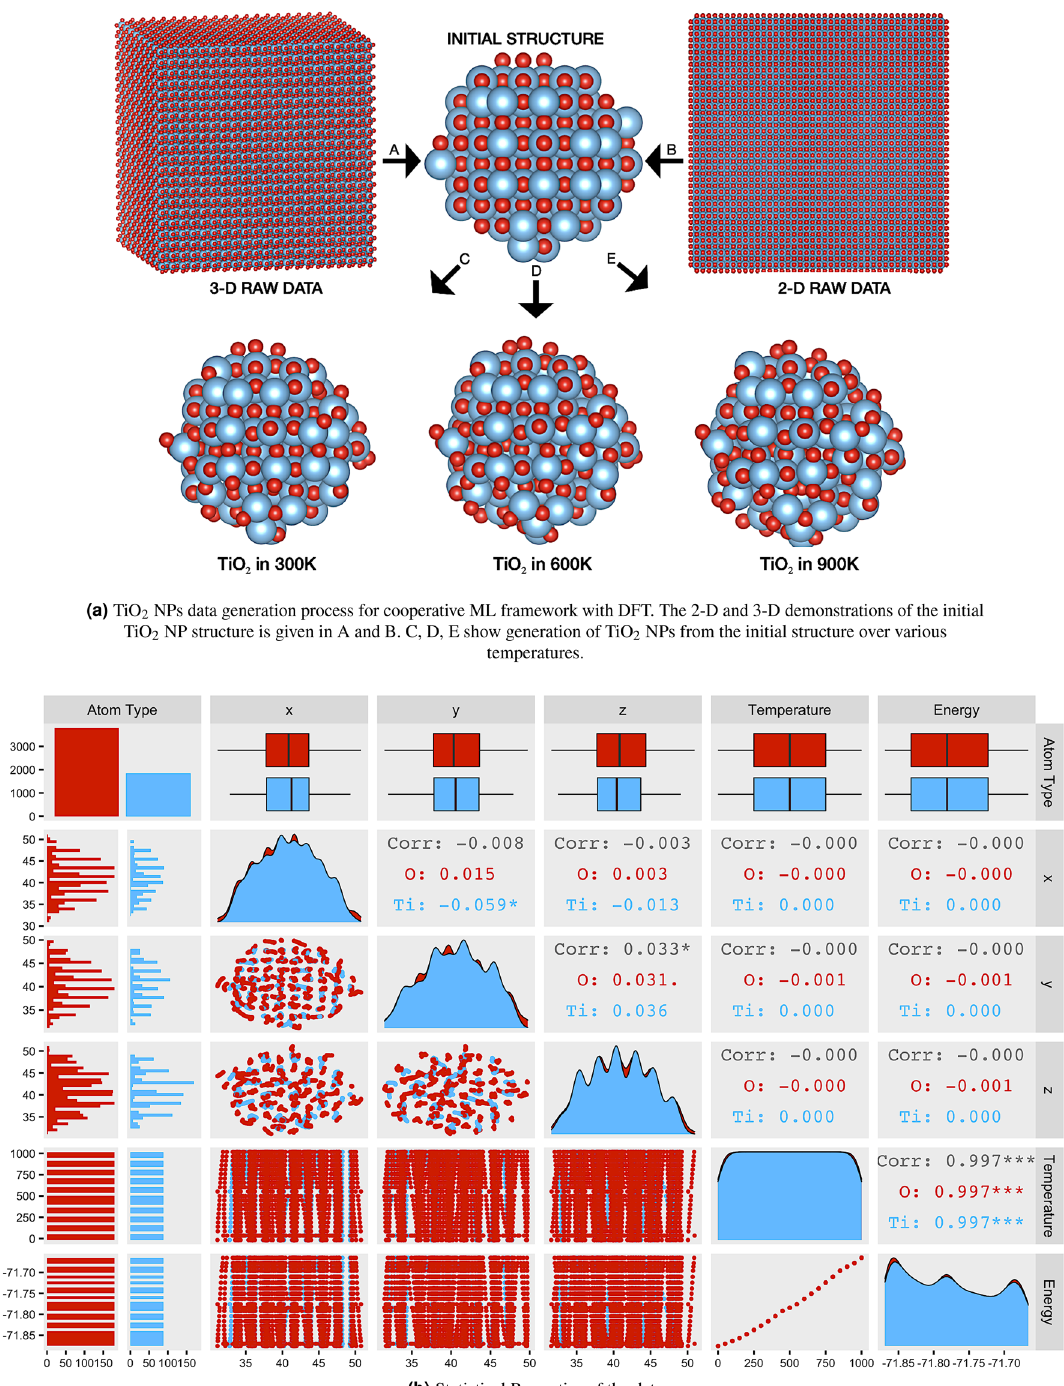
Figure 4. The summary of statistical properties of training data. The abscissa and ordinate show the variable values. Red and blue colors represent O and Ti atoms, respectively. Each input feature and bivariate relationships between the input variables are visualized depending on Ti and O